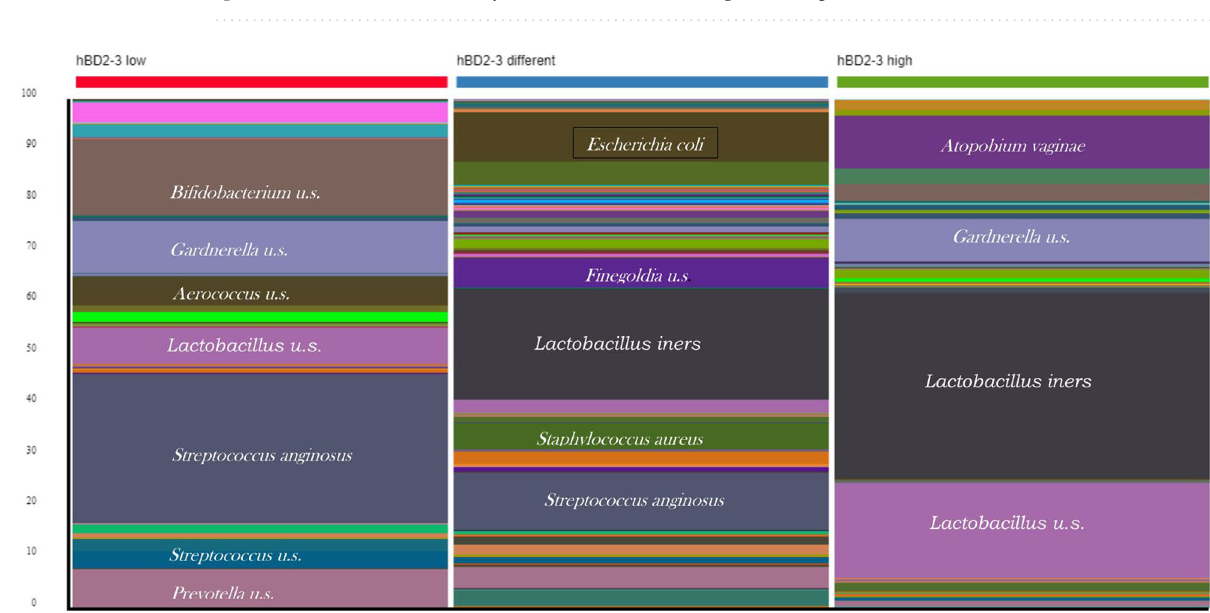
Figure 5. Vaginal microbial composition distribution according to the local levels of defensins. The prevalence of L. iners increases in parallel with the increase in hBD2-3 levels, while the prevalence of S anginosus